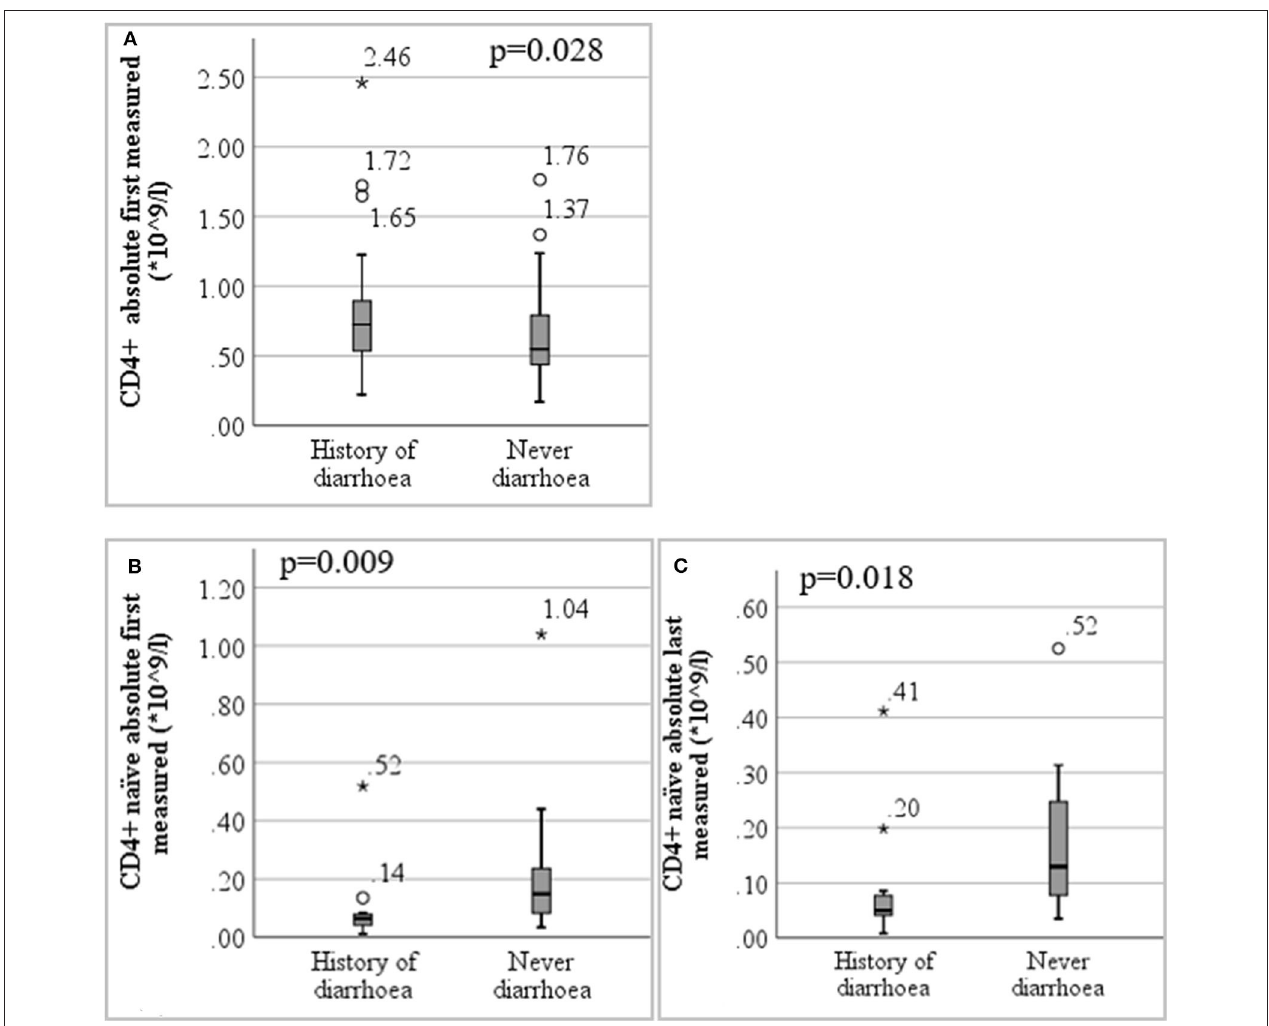
FIGURE 3 | Boxplot of lymphocyte immunophenotyping results detailing (A) first measured CD4 + T-lymphocytes in patients with and without diarrhoea ( n = 138) (B) first measured CD4 + naïve T-lymphocytes in patients with and without diarrhoea ( n = 28) (C) last measured CD4 + naïve T-lymphocytes in patients with and without diarrhoea ( n = 28). *are extreme outlier values (more than three interquartile ranges from the 25 th or 75 th percentile